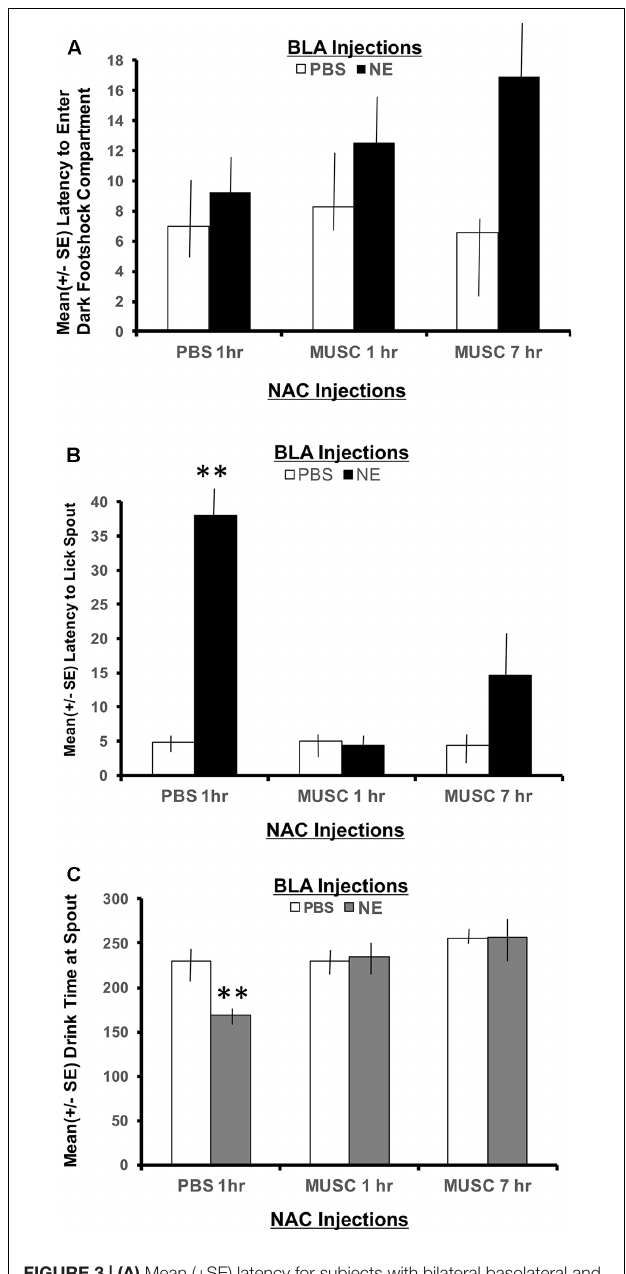
FIGURE 3 | (A) Mean (+SE) latency for subjects with bilateral basolateral and accumbens shell cannulae implants to enter the compartment where shock was delivered 24 h earlier. There were no group differences in the time it took animals to enter the shock context. A 2 × 2 ANOVA revealed no significant differences between PBS controls and all other treatment groups to enter the dark, footshock compartment of the apparatus. (B) Mean (+SE) latency for animals with basolateral amygdala and accumbens shell cannulae implants to lick the spout after entering the shock compartment. Although all groups readily entered the dark compartment, only animals given norepinephrine (NE) in the basolateral amygdala (BLA) and PBS in the accumbens (NAC) took significantly longer to traverse the dark compartment and initiate licking from the spout ( ∗∗ p < 0.01). The enhancement produced by BLA infusion of NE was blocked by intra-accumbens suppression of neuronal activity with Muscimol either 1 or 7 h following the NE injections. ∗∗ denotes p < 0.01.